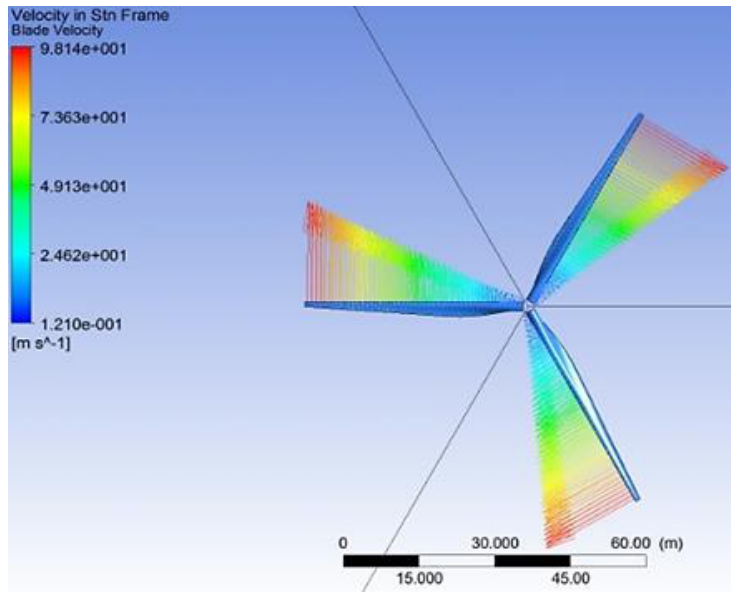
Figure 13. Illustration of the local wind turbine blade velocity. The wind velocity streamline shows the velocity of the fluid domain around the three wind turbine blades as in Figure 14.